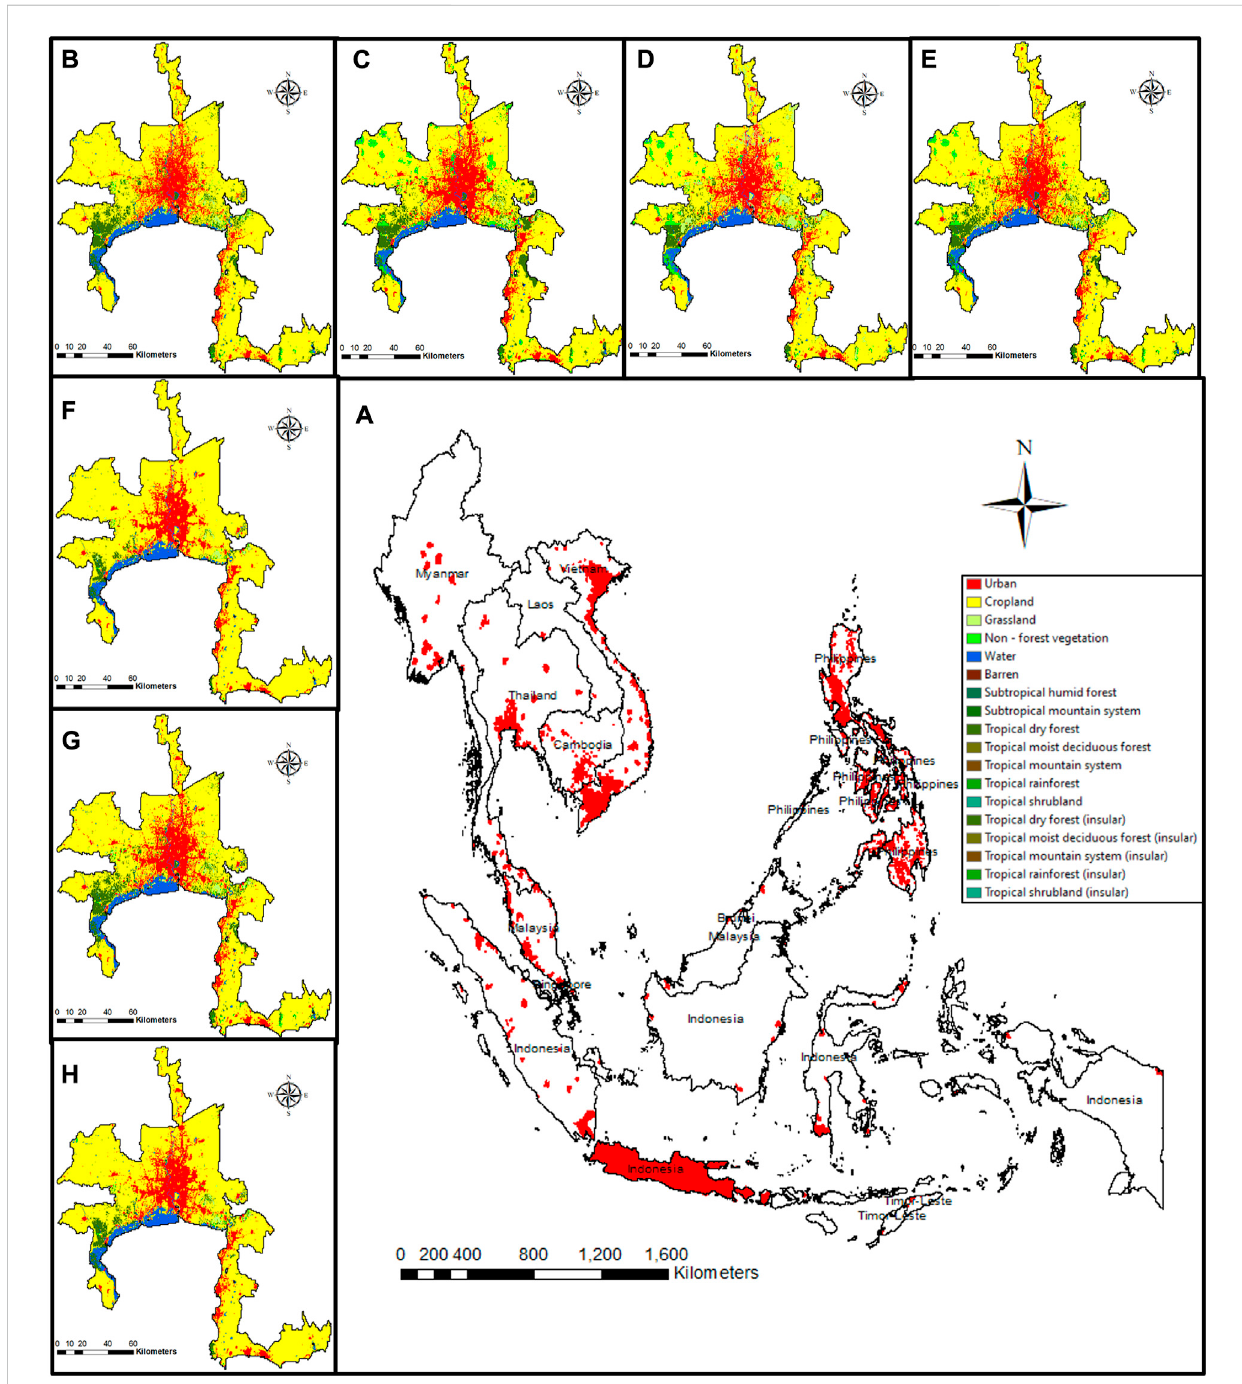
FIGURE 1 (A) SEA urban clusters (in red) derived for year 2015 based on GPWv4 population data; (B) 2015 Bangkok urban cluster land cover map; Bangkok urbanclusterprojectedlandcovermapfortheyear2050for (C) SSP1RCP2.6; (D) SSP2RCP4.5; (E) SSP3RCP7.0; (F) SSP4RCP3.4; (G) SSP4RCP6.0; (H) SSP5 RCP 8.5. Only the urban land use legend (clusters) are depicted in panel (A) for